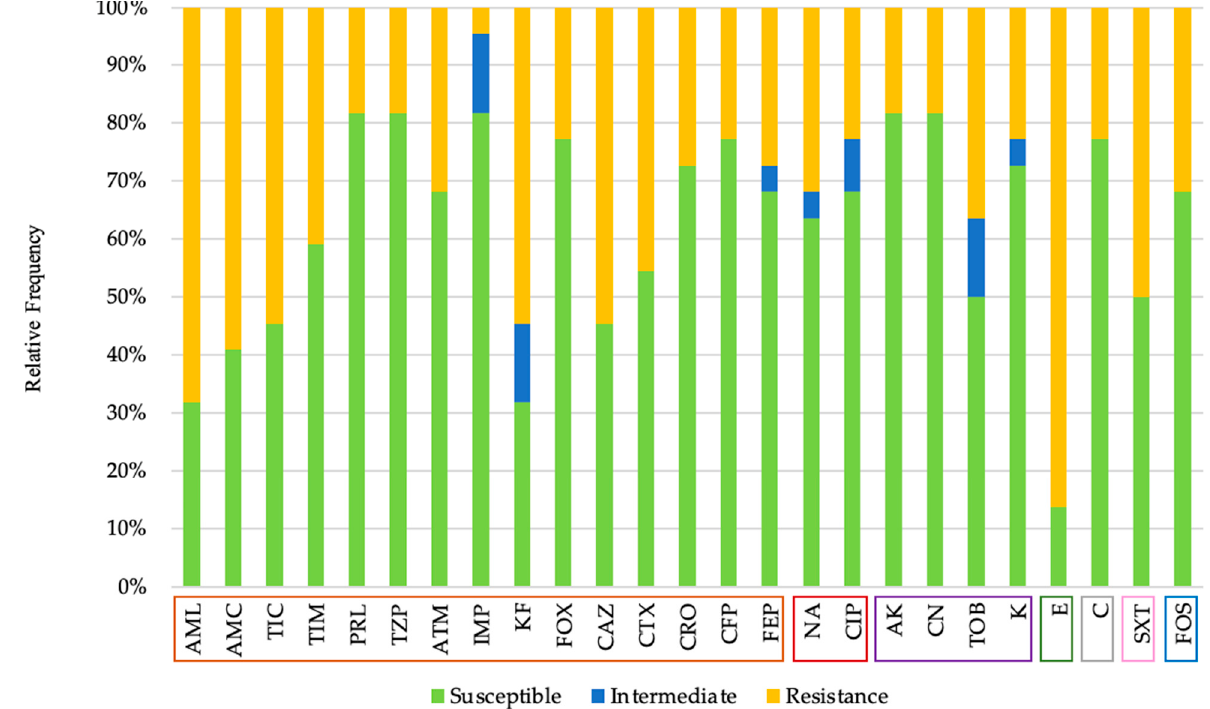
Figure 1. Antibiotic susceptibility profile of Gram-negative isolates, according to the following seven classes: beta-lactams (orange; Amoxicillin (AML), Amoxicillin/Clavulanic Acid (AMC), Ticarcillin (TIC), Ticarcillin/Clavulanic Acid (TIM), Piperacillin (PRL), Piperacillin/Tazobactam (TZP), Aztreonam (ATM), Imipenem (IMP), Cephalothin (KF), Cefoxitin (FOX), Ceftazidime (CAZ), Cefotaxime (CTX), Ceftriaxone (CRO), Cefoperazone (CFP), Cefepime (FEP)), quinolones (brown; Nalidixic Acid (NA), Ciprofloxacin (CIP)), aminoglycosides (violet; Amikacin (AK), Gentamicin (CN), Tobramycin (TOB), Kanamycin (K)), macrolides (green; Erythromycin (E)), amphenicols, (grey; Chloramphenicol (C)), sulfamides (pink; Sulfamethoxazole/Trimethoprim (SxT)) and phosphonic acid derivates group (blue; Fosfomycin (FOS)). Table 1. Description of the biofilm formation ability of the isolates (six from twenty-two) according to the classification proposed by Stepanovi´c and colleagues. Legend: (0) OD ≤ 2 ×